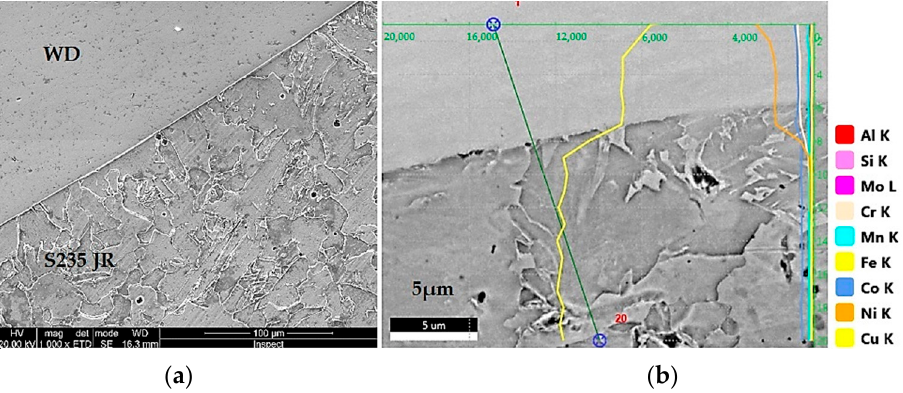
Figure 7. Transition from weld metal to S235 JR: ( a ) fusion line between WD and unalloyed steel; ( b ) distribution of the main chemical elements in this area.